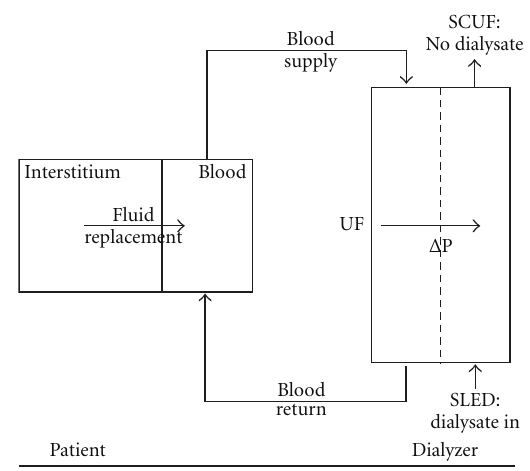
Figure 1: Dialytic techniques used in decompensated heart failure. Slow continuous ultrafiltration (SCUF) uses a hydrostatic pressure di ff erence ( Δ P) between the blood and nonblood sides of the membrane (dotted line within the dialyzer) to remove water and solutes from the plasma by ultrafiltration. Sustained low-e ffi ciency dialysis (SLED) has the additional feature of dialysis fluid passed through the nonblood compartment in a countercurrent direction to the blood flow. Fluid removed from the blood must be replaced by transfer from the interstitial compartment. Failure of this fluid recovery will result in hemodynamic